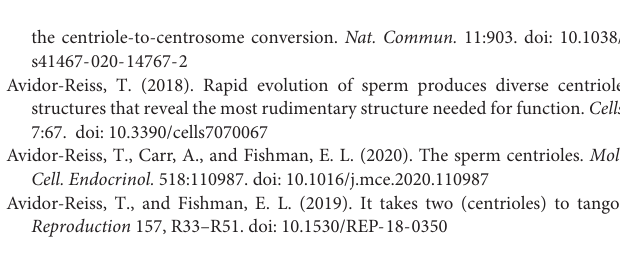
Supplementary Table 1 | Patient information. Excel file containing fertility and semen analysis information of all